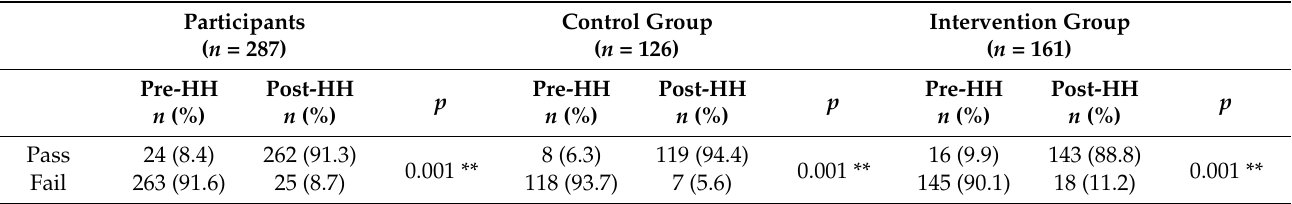
Table 2. Intervention data